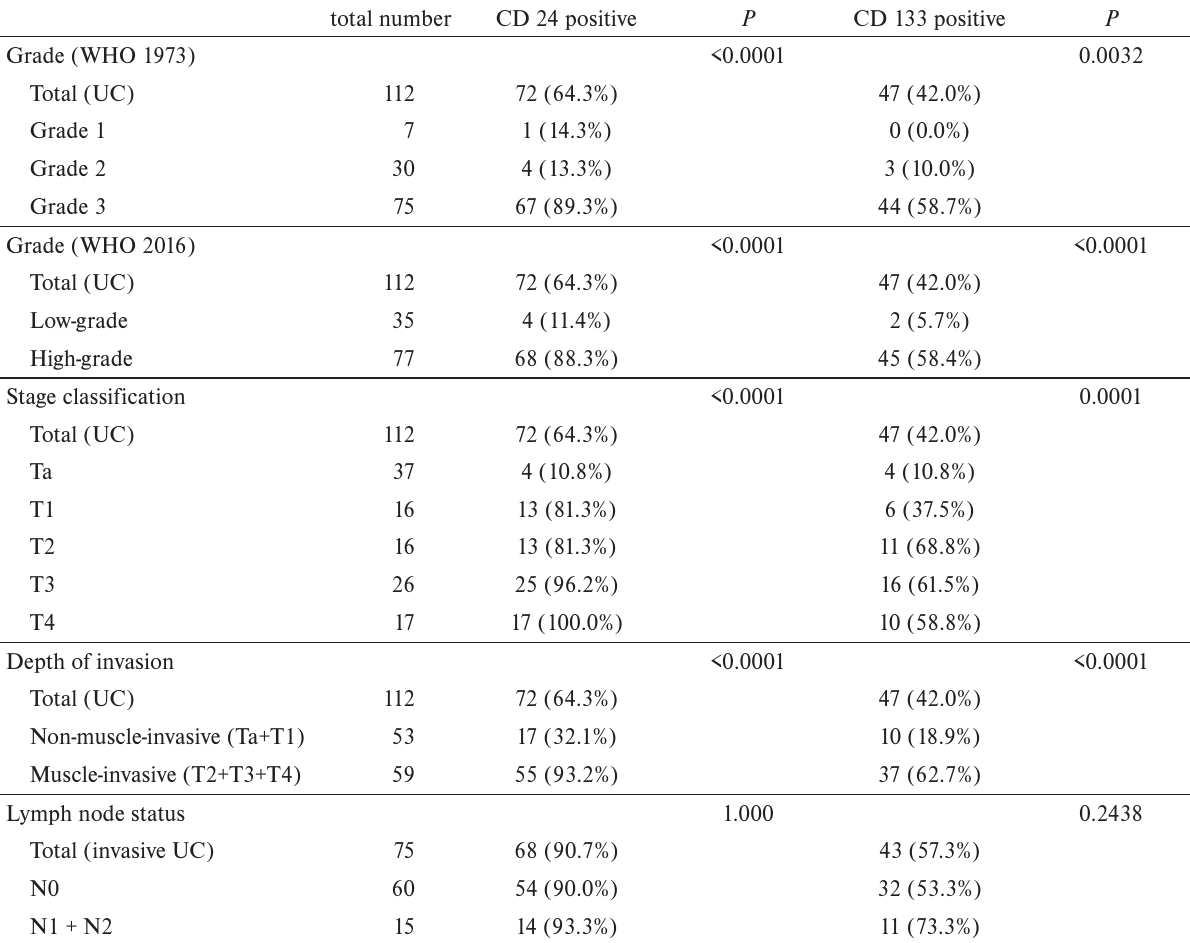
Table 2. Association of CD24 and CD133 expression with the histopathological characteristics of urinary bladder